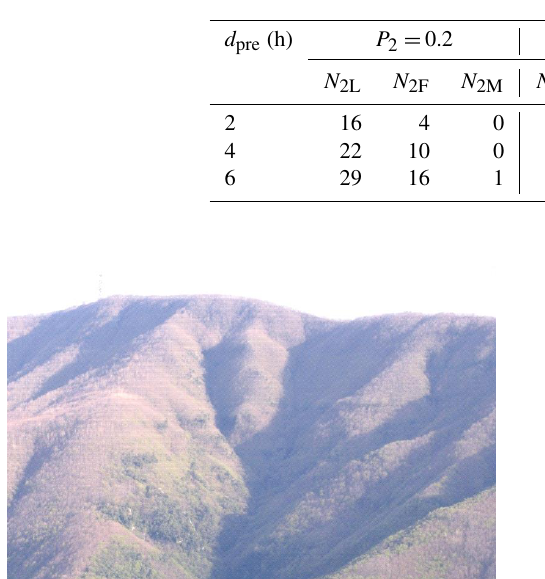
Table 3. Stochastic approach to early warning: numbers of launched ( N 2L ) , false ( N 2F ) and missing ( N 2M ) alarms at the slope of Pessinetto for three different lead times t pre and three different choices of the probability of alarm activation P 2 . For each lead time, the system carried out 964 predictions between 11 September 1991 and 15 June 2004 (validation period).